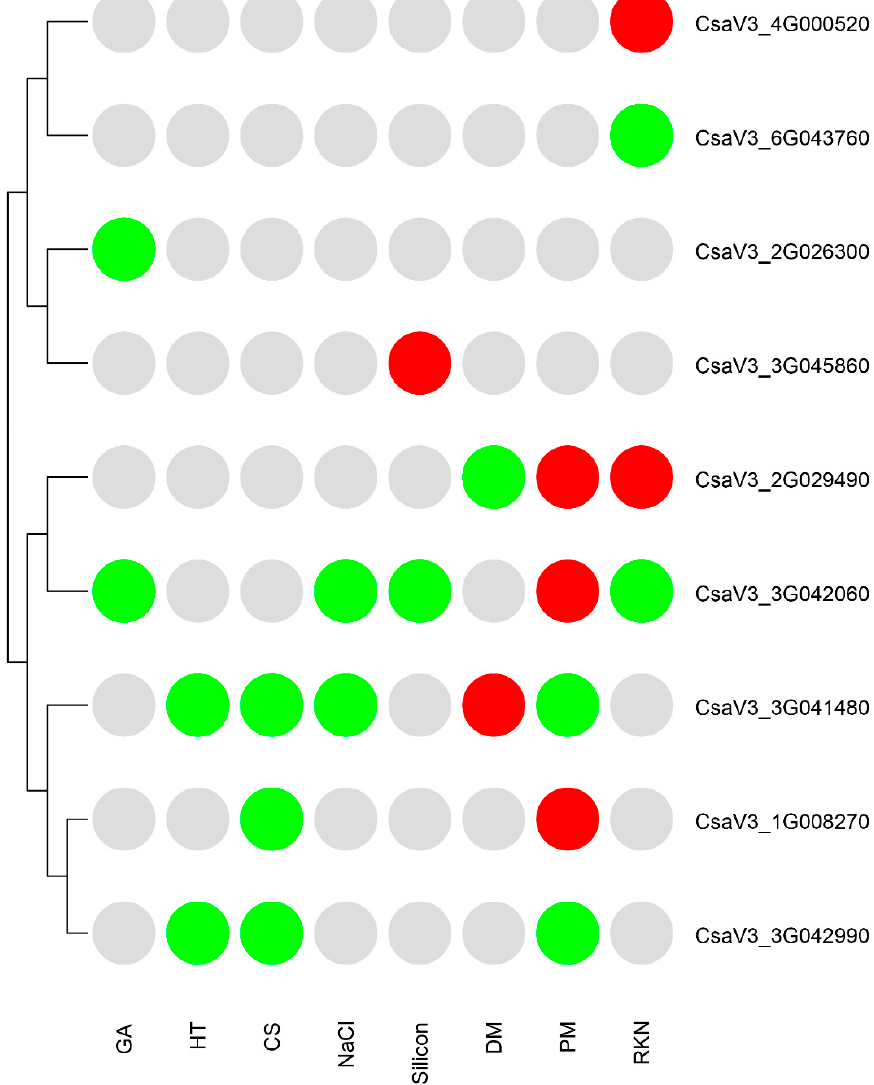
Figure 9. Expression patterns heatmap of cucumber GASA family genes under abiotic and biotic stresses. GA: gibberellin treatment; HT: high temperature stress; CS: low temperature stress; NaCl: salt stress; Silicon: silicon stress; DM: downy mildew stress; PM: powdery mildew stress; RKN: root-knot nematode stress. Gray color represents expression level that was not changed, red color represents up-regulated expression, green color represents down-regulated expression.